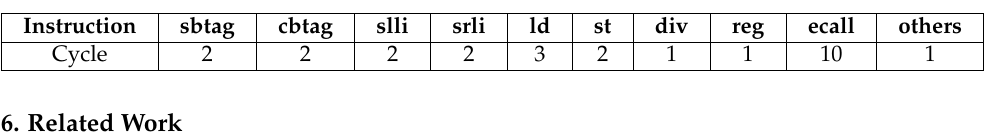
Table 3. Weighted cycles for measuring the Bratter execution time